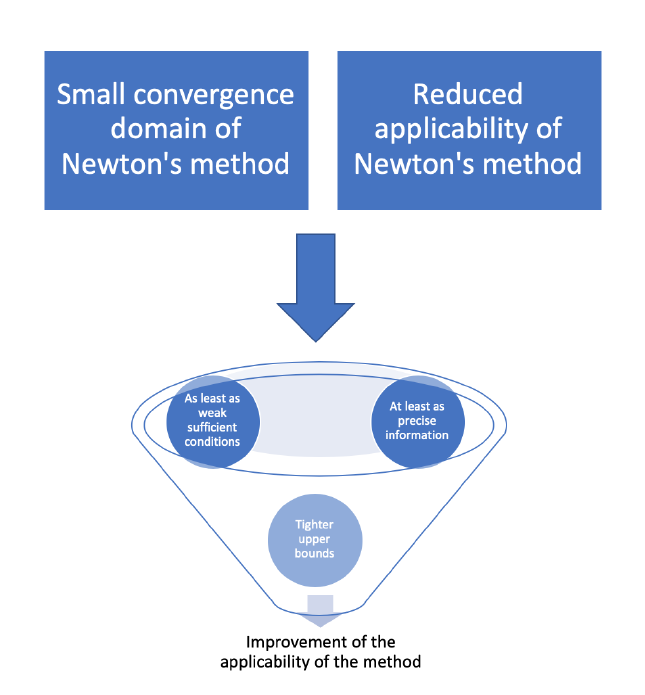
Figure 1. General sketch of the